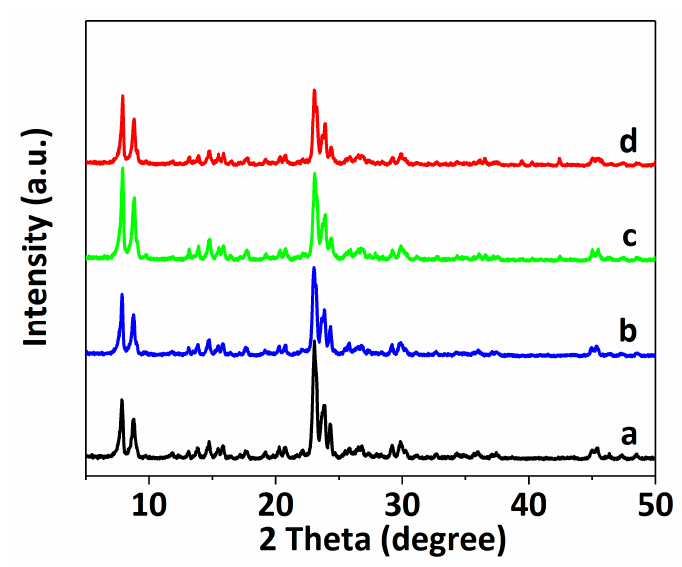
Figure 1. X-ray diffraction (XRD) patterns of (a) H-ZSM-5, (b) Fe/ZSM-5, (c) H-ZSM-5-ST and (d) Fe/ZSM-5-ST.